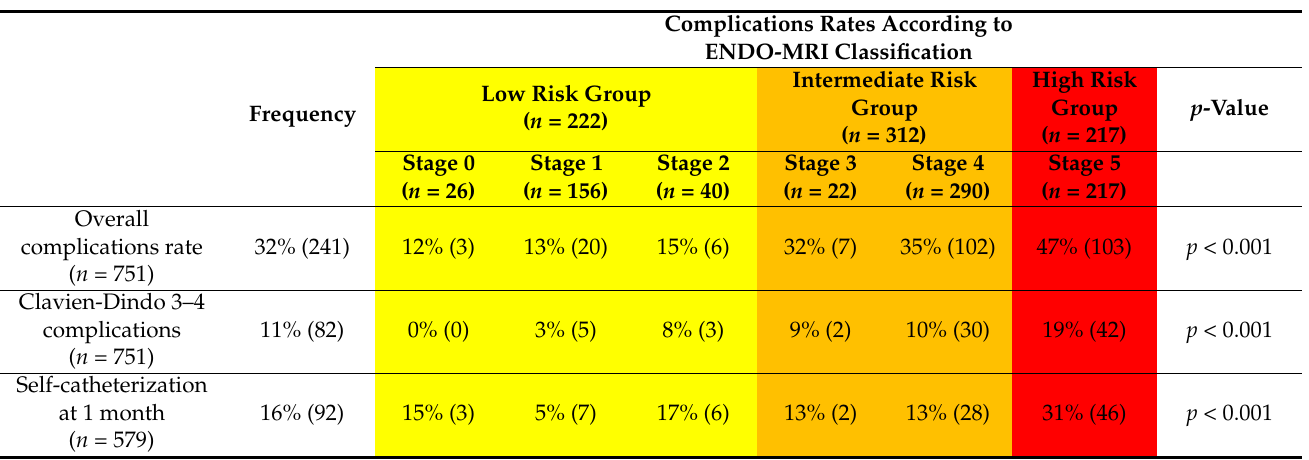
Table 4. Rates of surgical complications according to Endo-Stage MRI classification and system of triage.